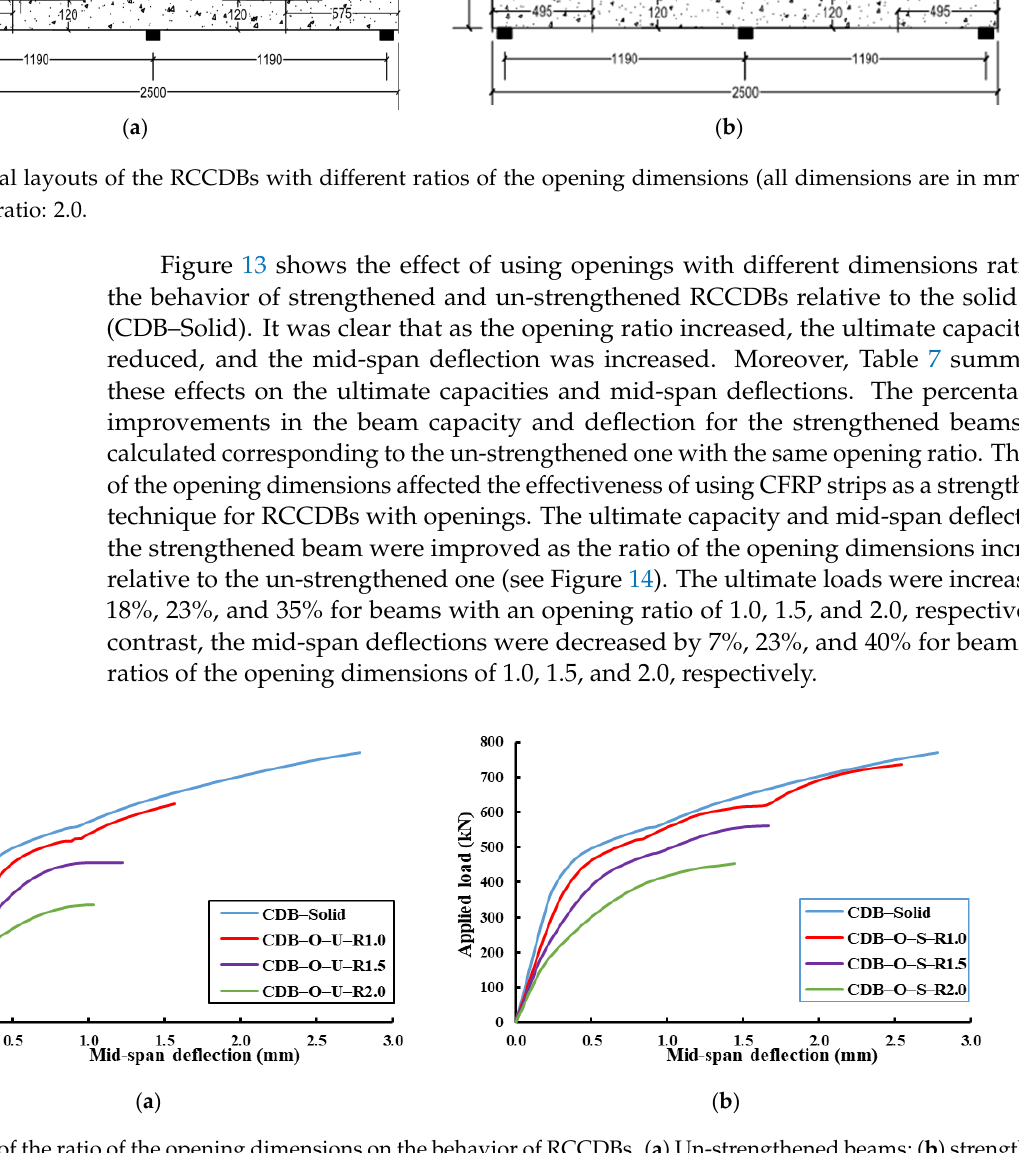
Figure 11. Crack patterns of the tested specimens in experimental setup and ABAQUS. ( a ) Specimen CDB – Solid; ( b ) spec- imen CDB – O – U; ( c ) specimen CDB – O – S.